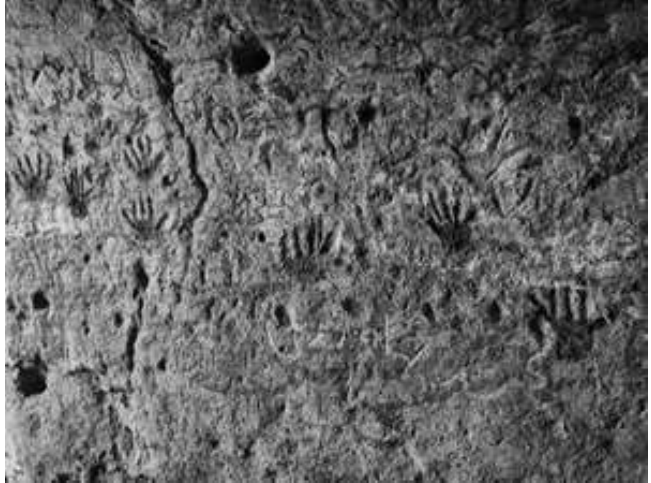
Figure 17. The hand petroglyphs of Karaftou Cave next to the cupules on the vertical surface of the